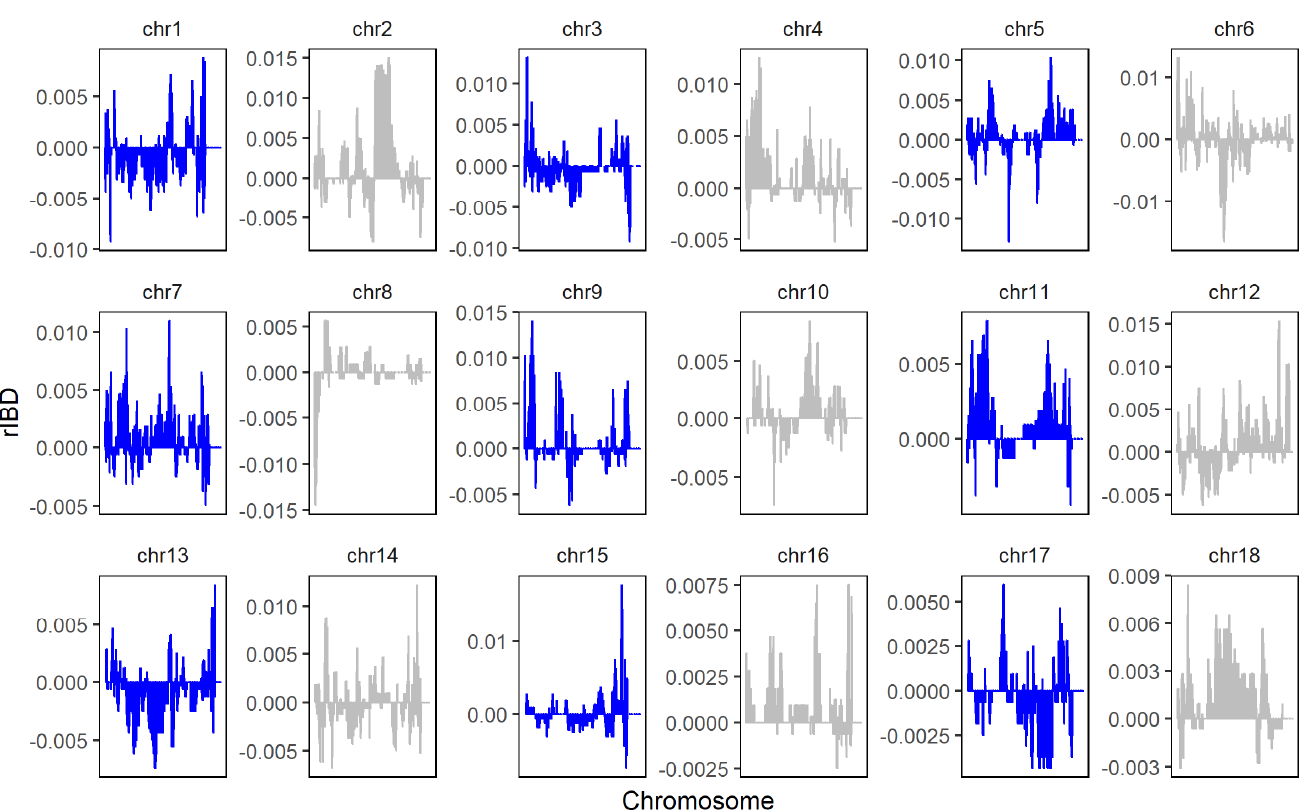
Figure 8. rIBD results of LU–LW and LU–YY pigs by GGRS. Positive values represent rIBD between LU and LW pigs, which means the sequence was introgressed from LW to LU pigs. Negative values represent rIBD between LU and YY pigs, which means the sequence was introgressed from YY to LU pigs.